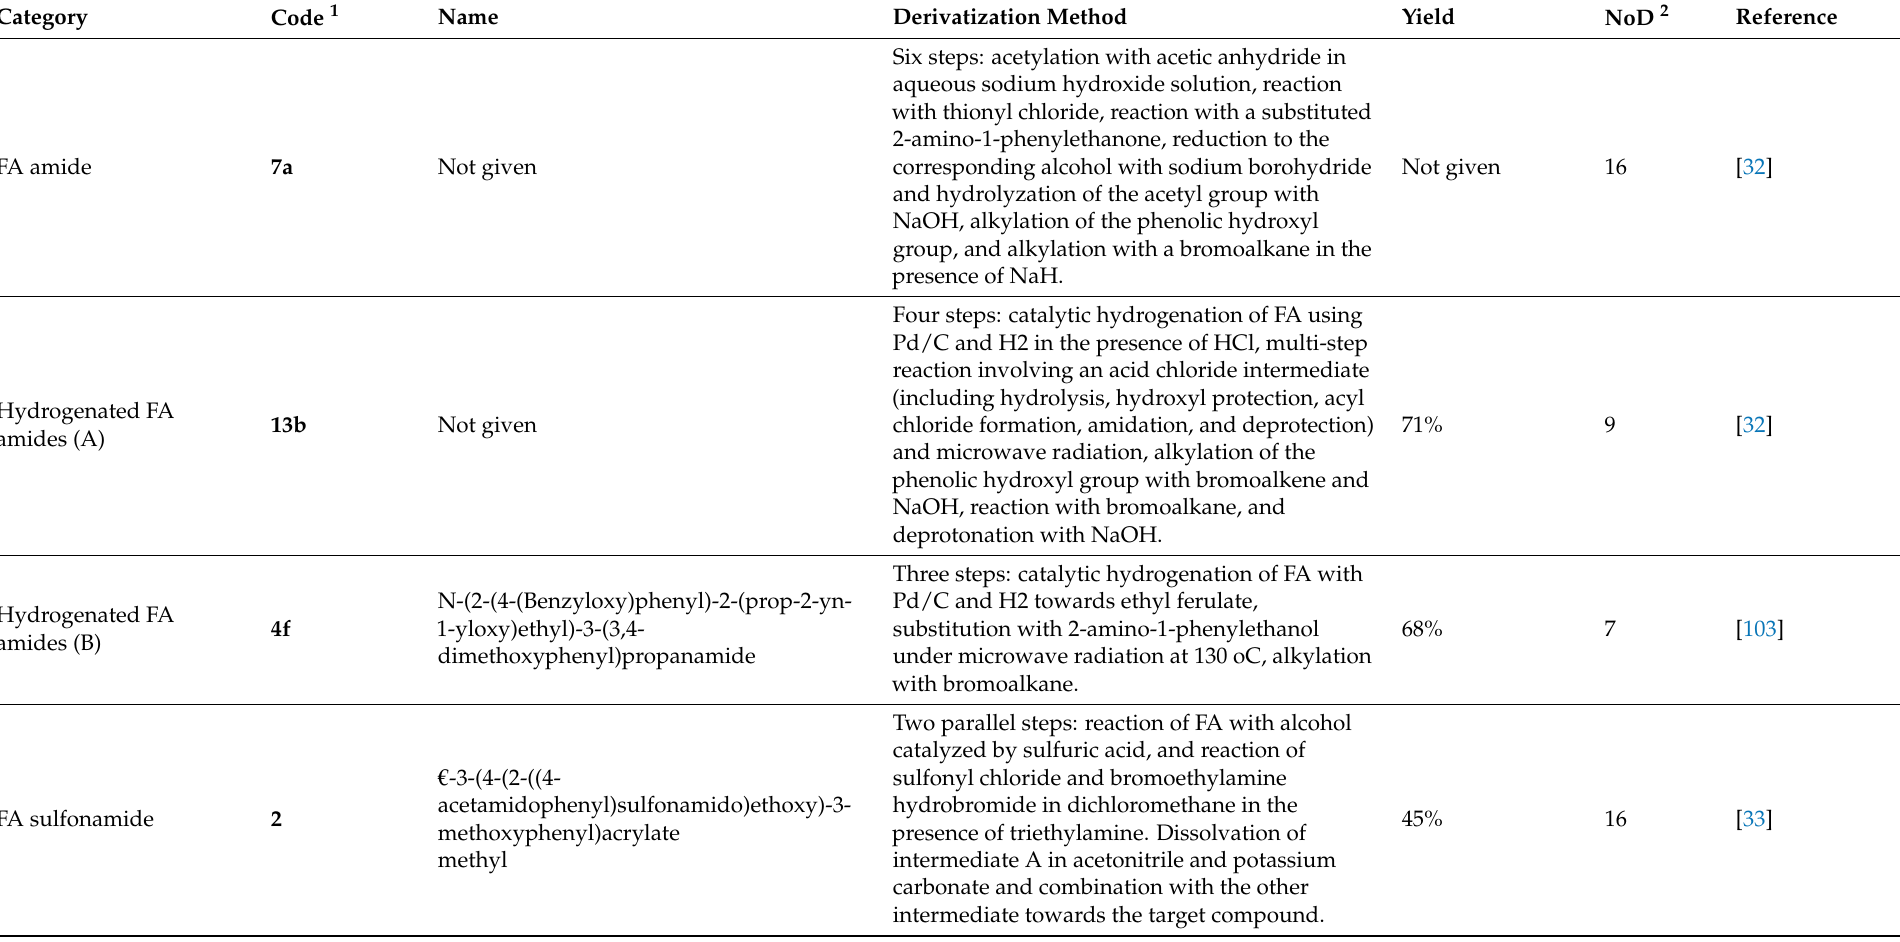
Table 3. Listing and synthesis method of chemically synthesized FA